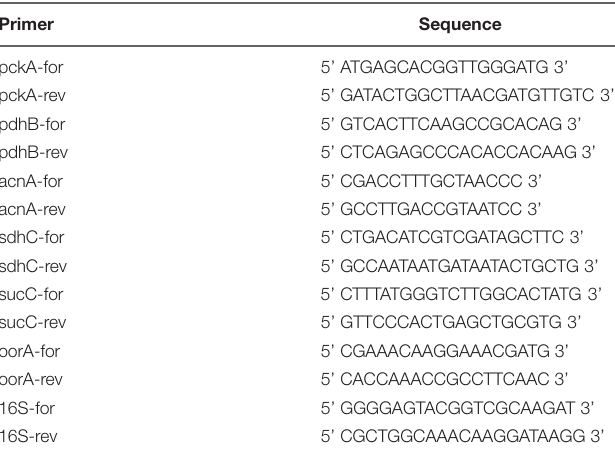
TABLE 2 | Primers used in quantitative real-time PCR